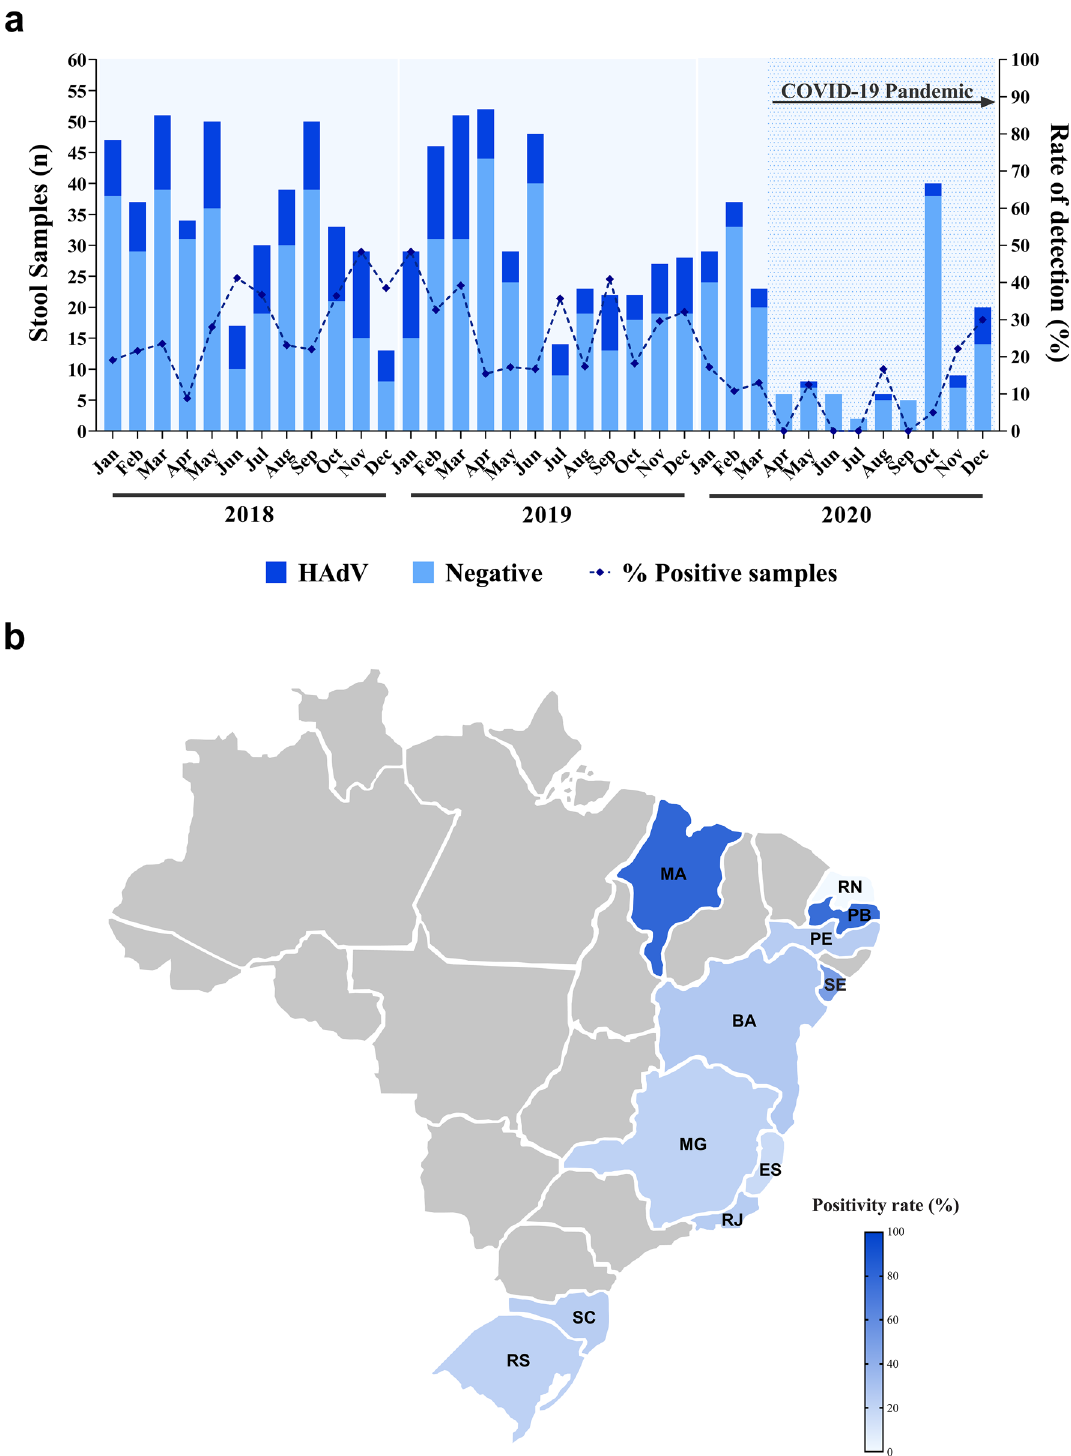
Figure 1. (a) Monthly distribution of tested acute gastroenteritis samples, HAdV-positive samples and detection rates in Brazil, 2018–2020. (b) Map of Brazil highlighting HAdV detection rates in each of the eleven states included in this three-year study. This figure was designed in Adobe Illustrator 26.0 (https:// www. adobe.